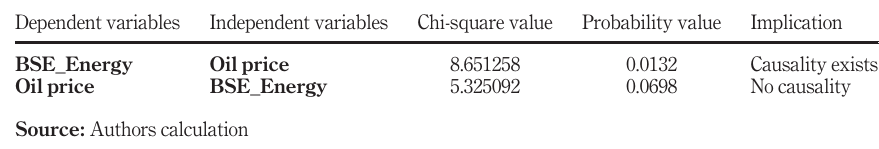
Table 9. Result of VEC Granger causality/ block